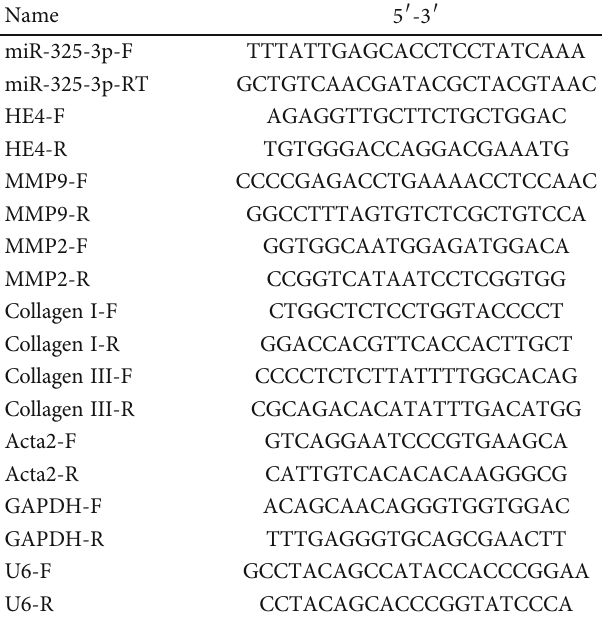
Table 1: The primers used in this